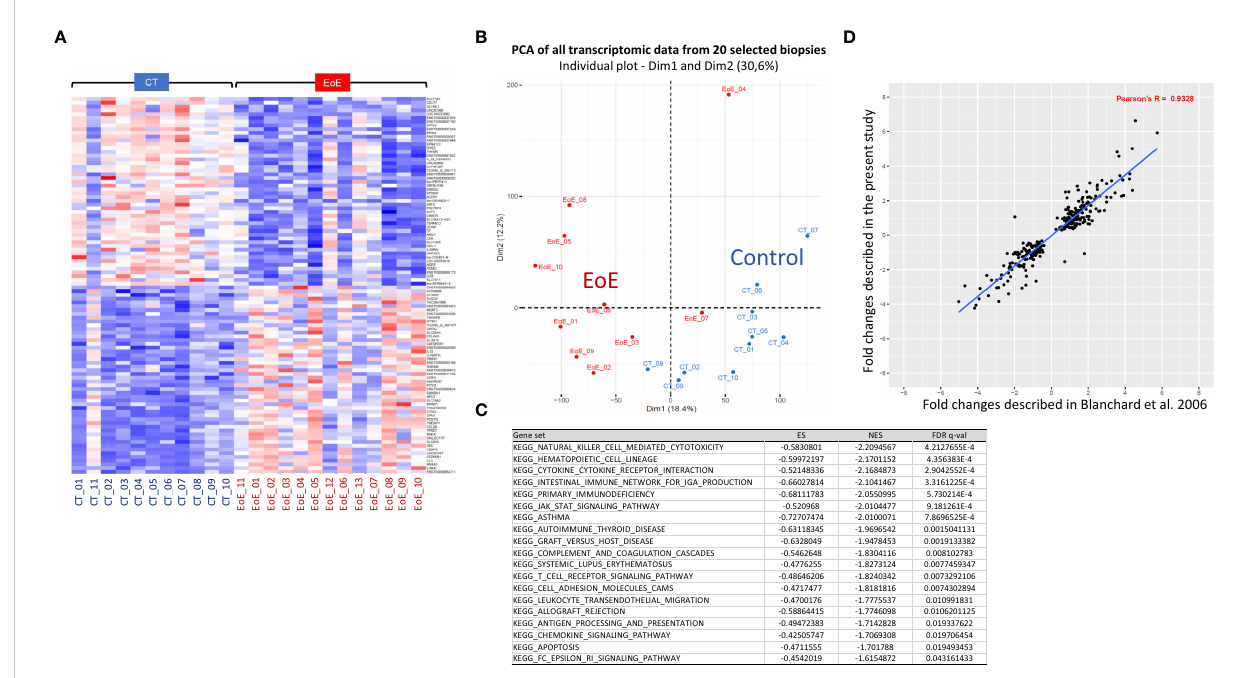
FIGURE 1 Transcriptomic signature of EoE in children from a French cohort. (A) Heatmap of the 50 most signi fi cantly upregulated (red) or downregulated (blue) transcripts obtained from biopsies of 11 CT and 13 EoE patients. Expression values are centered on the mean. The magnitude of the gene changes is proportional to the darkness of the color. Each column represents a separate individual and each line a DE gene. (B) Non-supervised multivariate analysis (PCA) of all transcriptomic data obtained from the 20 selected biopsies (CT: blue, n = 10; EoE: red, n = 10), showing natural separation of EoE versus controls. (C) Signi fi cantly enriched pathways in EoE patients (n = 10) relative to controls (n = 10), identi fi ed through GSEA and considering all analyzed genes. The 19 MSigDB gene sets that were enriched by a FDR q-value < 0.05 are shown. (D) . Correlation of the fold changes of 300 DE genes described in (6) (x-axis) compared to our study (y-axis). For functionally organized pathway network identi fi ed with ClueGO using the 4,767 identi fi ed DE genes, see Data Sheet